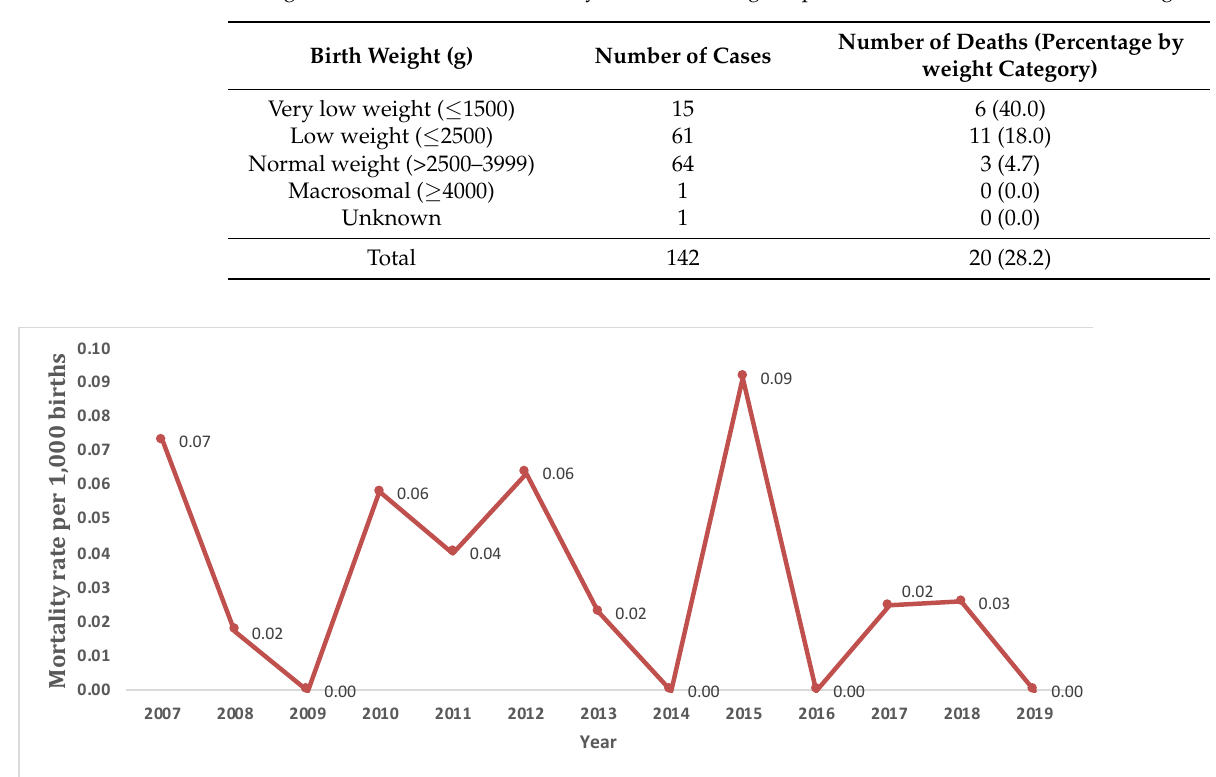
Table 3. Distribution of cases with oesophageal atresia according to Vogt ’ s classification or loca- tion of the fistula during the period 2007 – 2019 in the Valencian Region. Type of Oesophageal Atresia